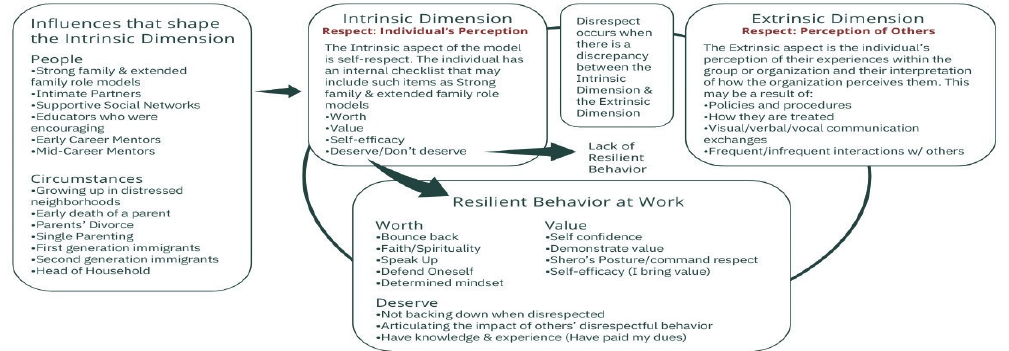
Figure 3. Disrespect/Respect/Resilience Model.